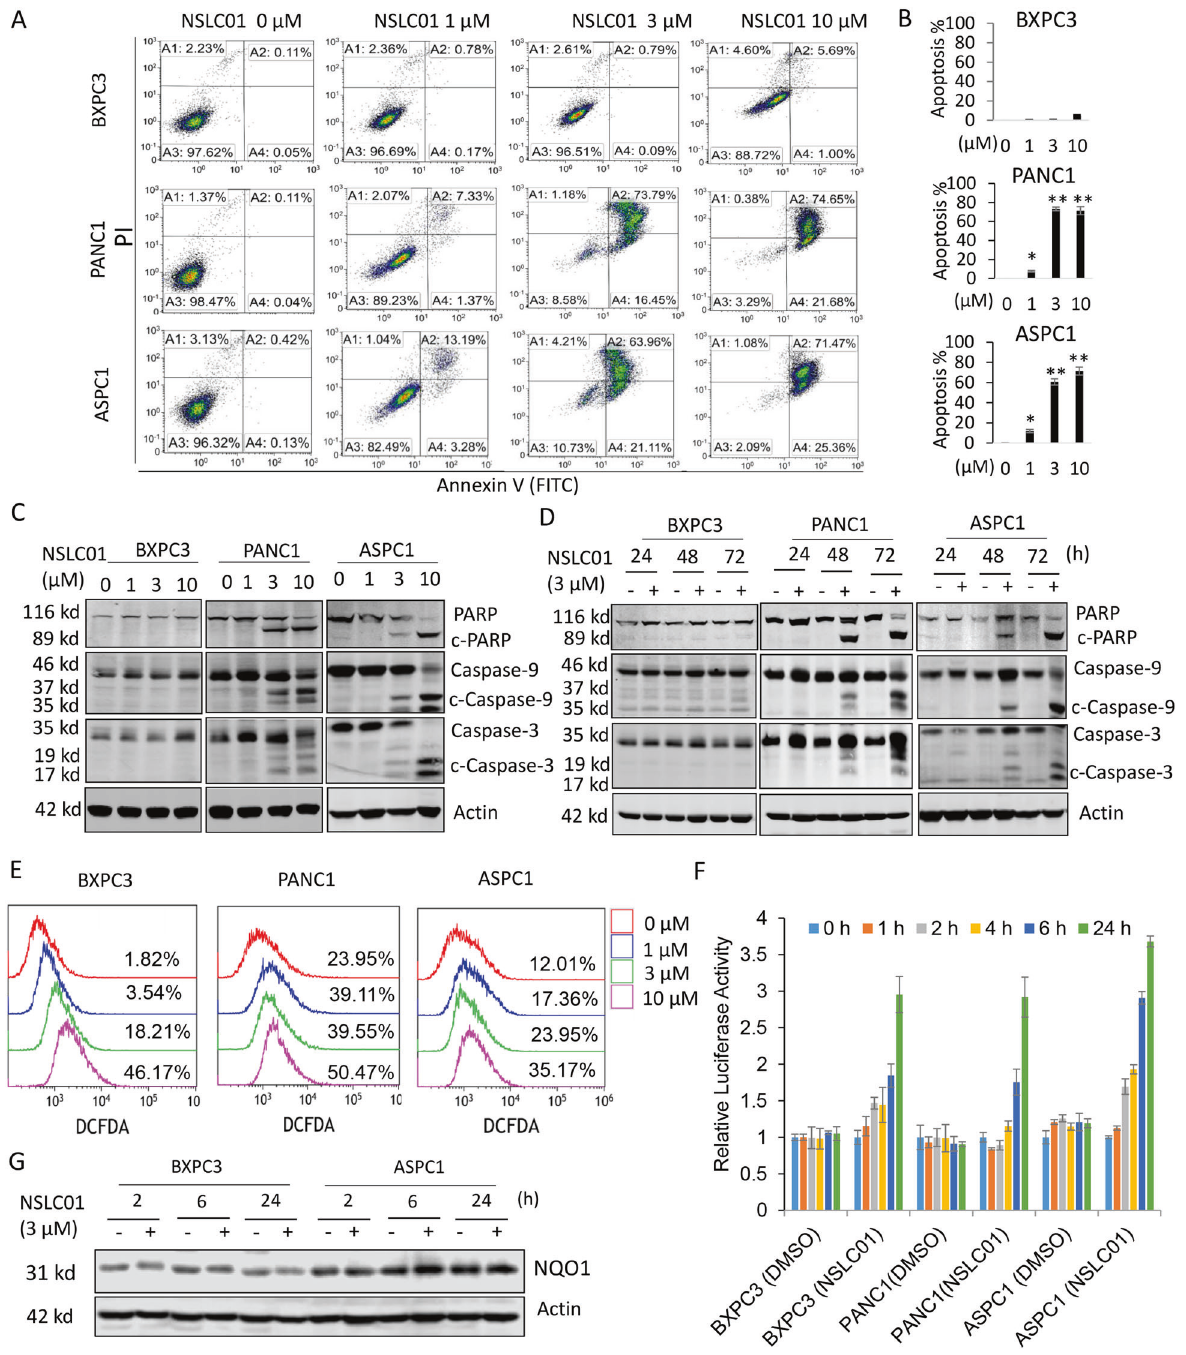
Fig. 2 NSLC01 induces apoptosis in pancreatic cancer cells. Cells were treated with various doses of NSLC01 for 48 h and then stained with propidium iodide (PI) and Annexin V FITC for fl ow cytometry analysis of apoptosis. A Representative results from triplicate experiments. B Quantitation of apoptosis populations. Data are presented as mean ± SD; n = 3; * P < 0.05; ** P < 0.01. C Western blot analysis at 48 h to measure apoptosis markers, cleave- (c-) PARP, c-caspase-3, and c-Caspase-9. D Western blot analysis to measure c-PARP, c-caspase-3, and c- caspase-9 in cells treated with 3 µM NSLC01 for various durations. E ROS measurements after treatment with various doses of NSLC01 for 24 h. F Cells were transfected with 1 µg of ARE-Luc promoter plasmids and 0.1 µg of actin-RLuc internal control plasmids, and after 24 h, cells were treated with NSLC01 at indicated time periods and ARE-Luc promoter reporter activity were measured. Data are presented as mean ± SD. There were no statistically signi fi cant differences between the cell types. G Western blotting analysis of NQO1 expression in BXPC3 and ASPC1 after treatment with NSLC01 for indicated